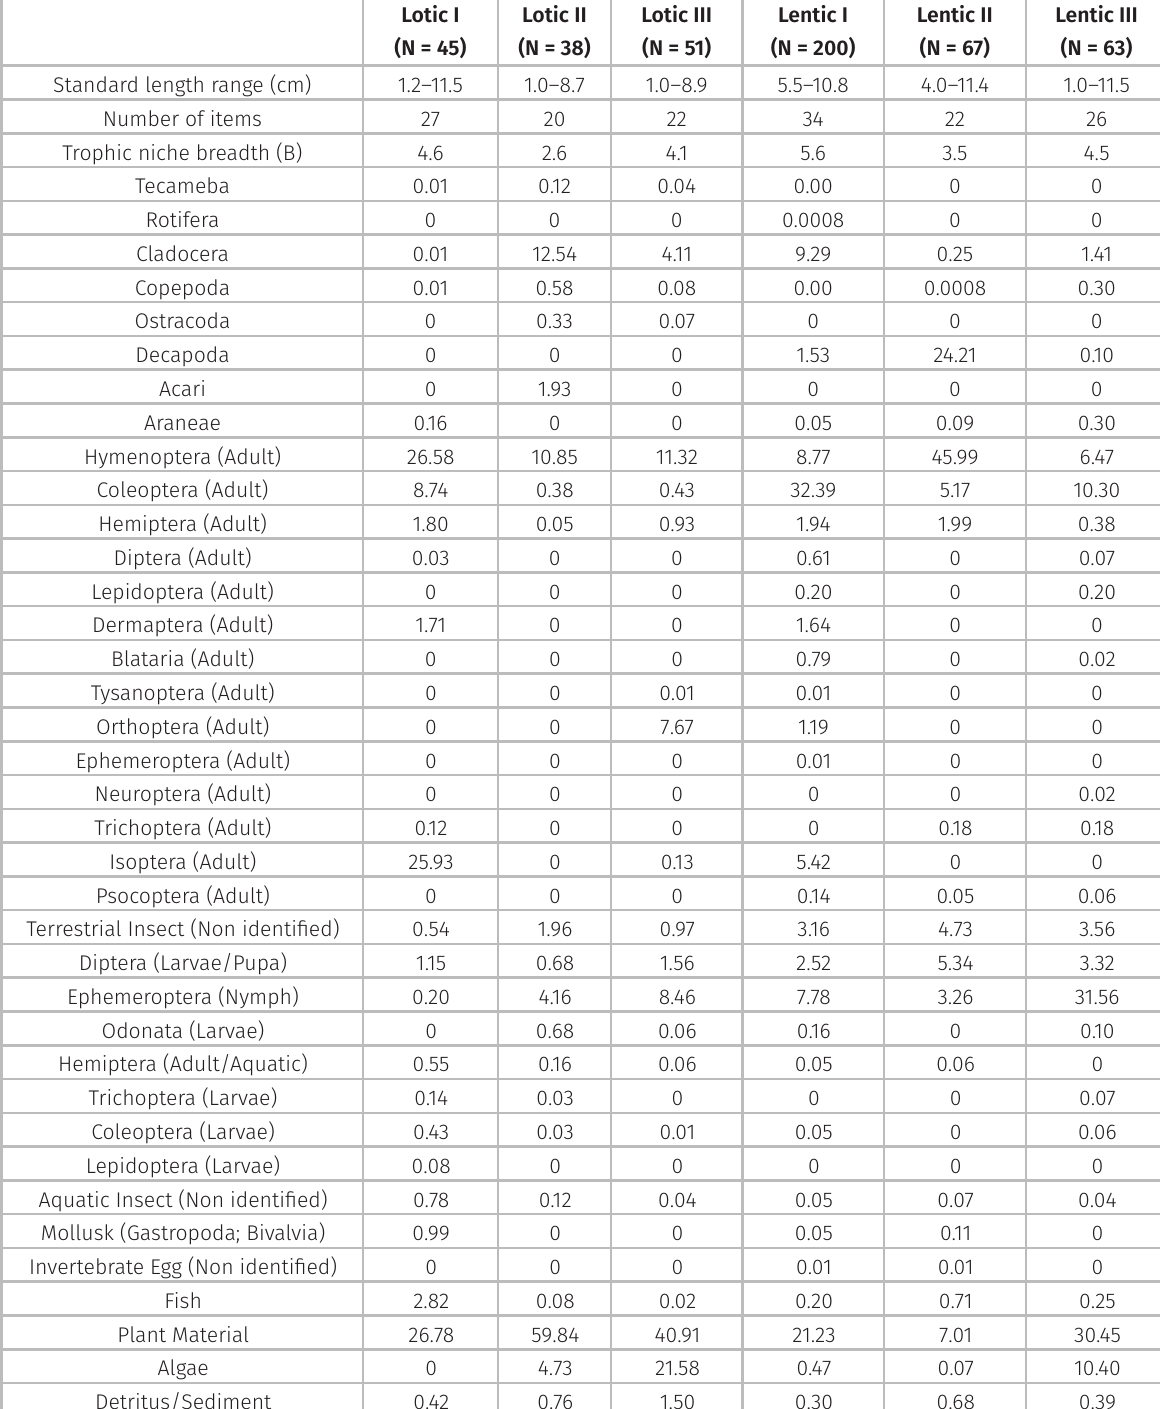
Table II. Variation in standard length range and number of individuals (N) selected for diet analysis; the number of items found in the diet, trophic niche breadth (B), and diet composition (% weight) of the food resources consumed by Astyanax lacustris in lotic and lentic sites influenced by the Chavantes Reservoir, Paranapanema